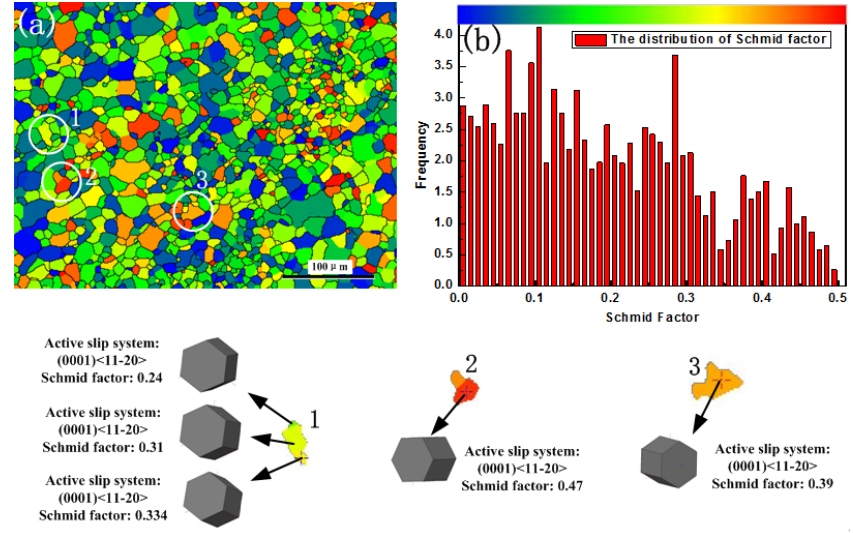
Figure 9. The Schmid factor distribution in the as-received material. ( a ) the distributions of the Schmid factor on the base metal; ( b ) the crystal shifts from hard orientation to soft orientation In Stage III during the crack propagation, large deformation is caused by the non-basal slip.